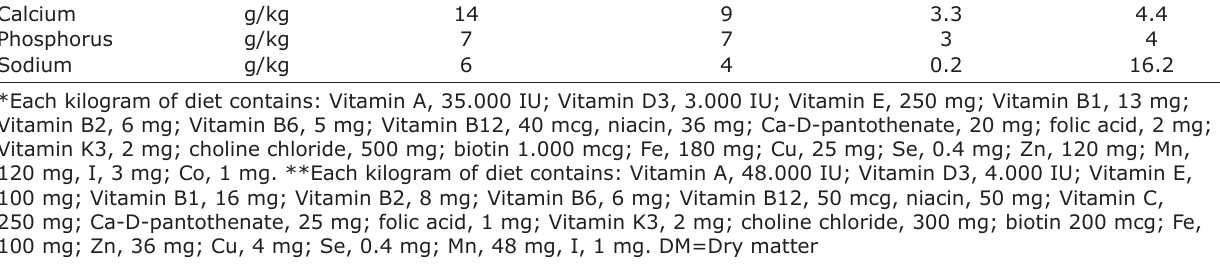
Table-1: Nutrients content per kg DM of diets used during calf rearing. Item Unit Prestarter* Milk replacer** Hay Barley flour Crude protein % Fat % Crude fiber Calcium g/kg